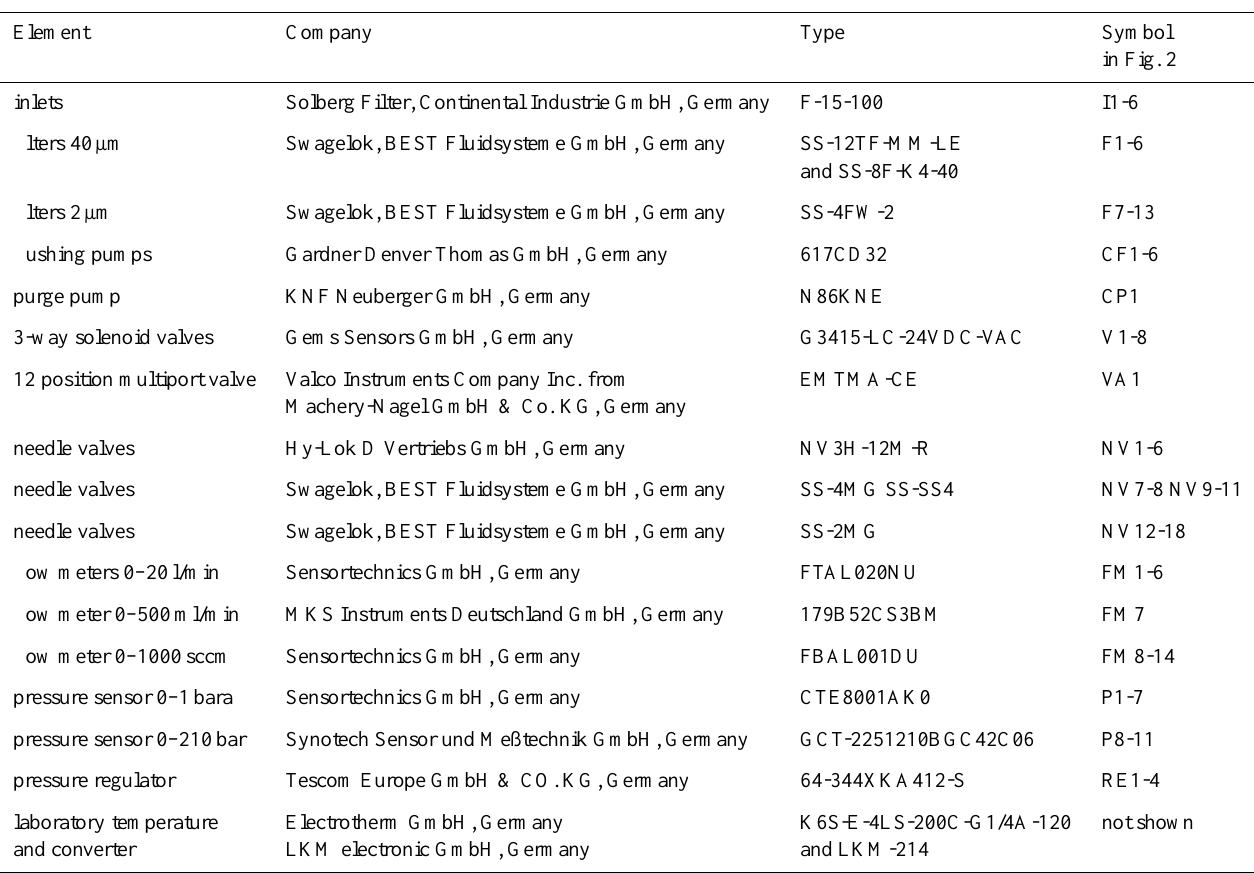
Table 1. Part list of ZOTTO